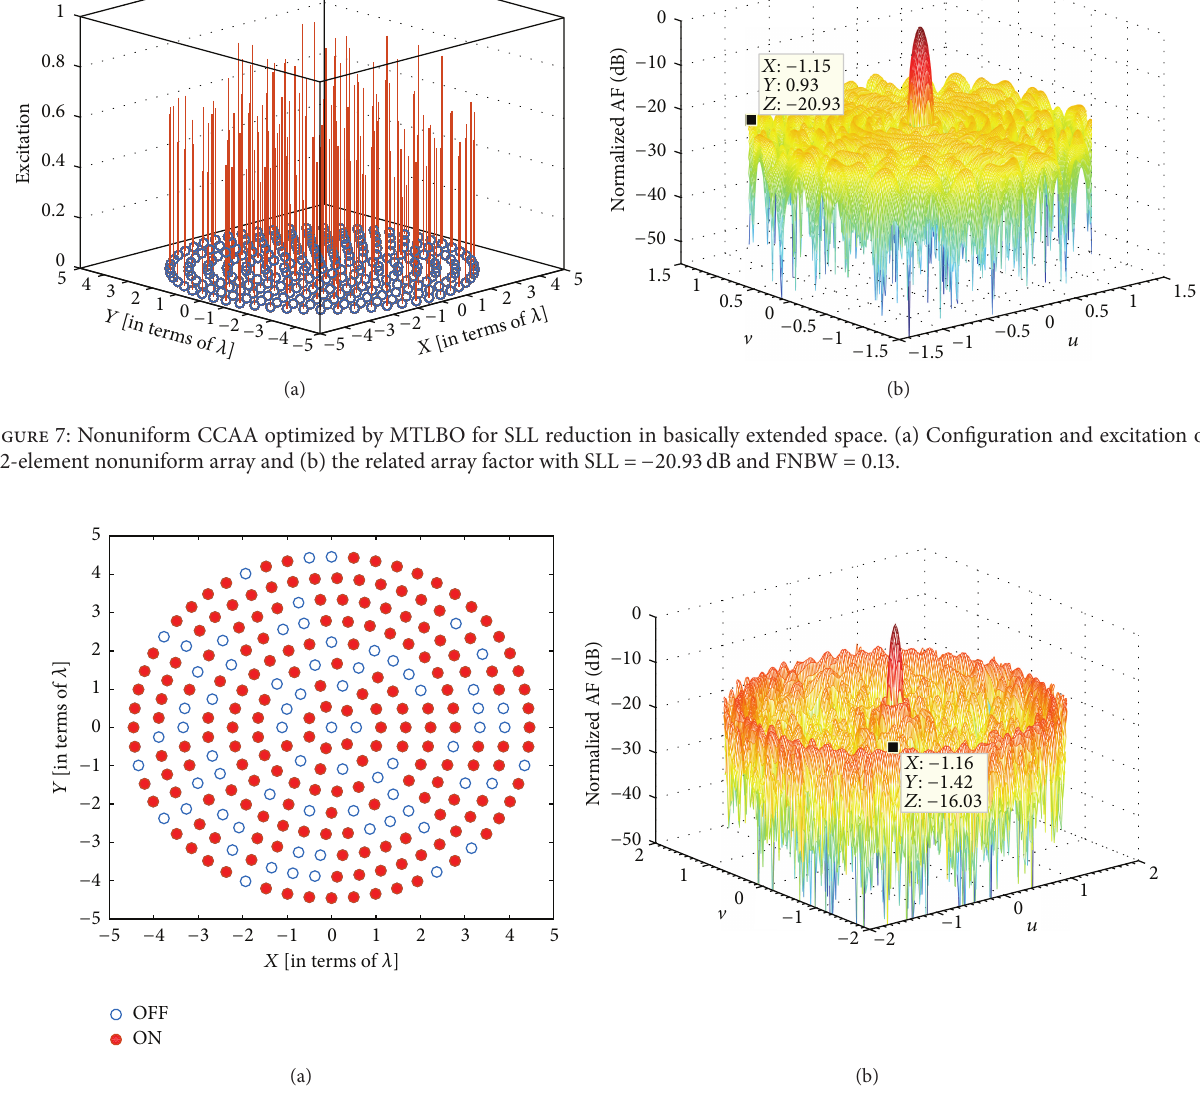
Figure 8: Uniform CCAA optimized by MTLBO for SLL reduction in adequately extended space. (a) Configuration of a 194-element uniform array and (b) the related array factor with SLL = − 16.0dB and FNBW = 0.13.